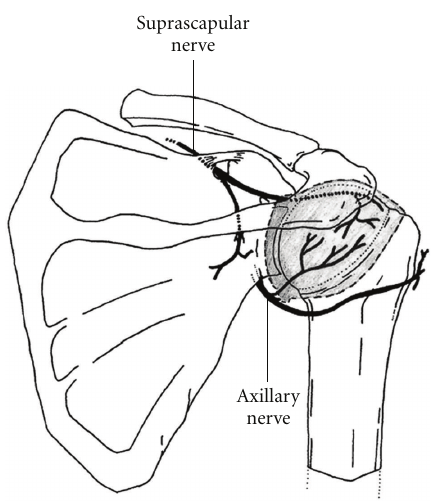
Figure 2: Posterior innervation of the shoulder joint. The supras- capular nerve and axillary nerve are the primary nerves supplying this region (Borgeat and Ekatodramis [1]). (Reprinted with permis- sion from